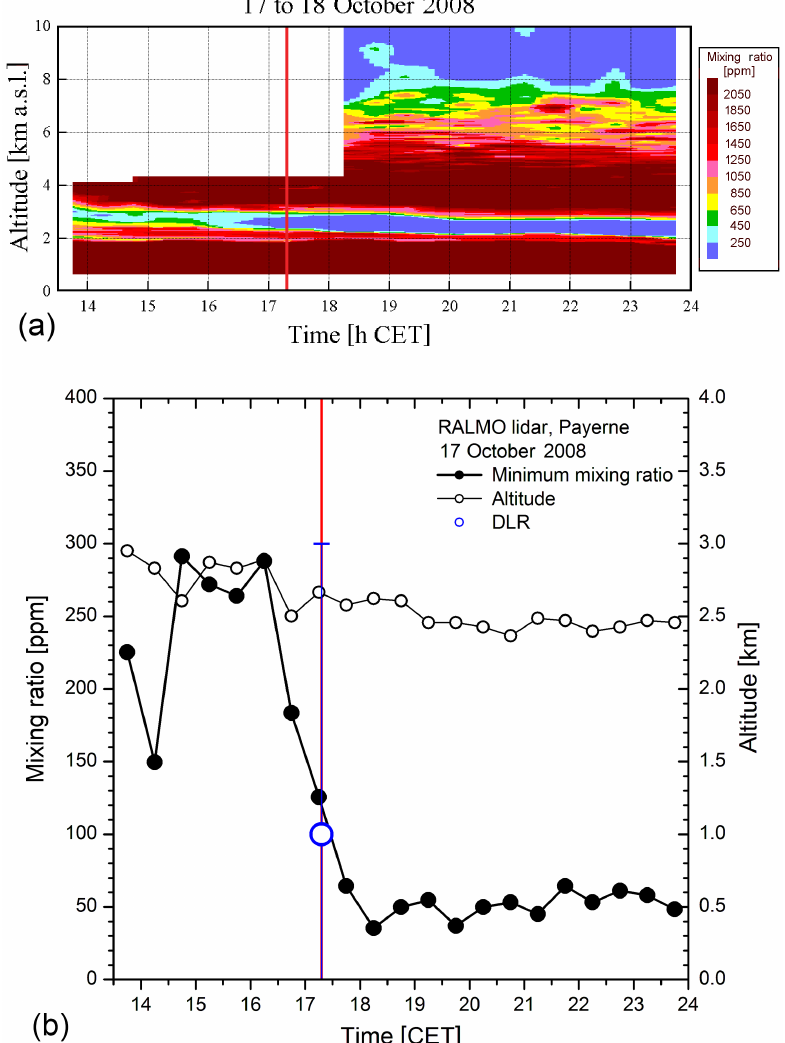
Figure 3. (a) Water-vapour time series of RALMO on 17 October 2008; the time of the aircraft overflight (17:18CET) is marked by a red vertical line. The figure is based on 0.5h averages, the times being centred in the respective measurement interval. Before 18:15CET the residual daylight background prevented measurements beyond the lower free troposphere. (b) Time series of the water-vapour minimum in the stratospheric intrusion layer on 17 October 2008, as recorded by RALMO, and the corresponding altitude; the time of the aircraft overflight (17:18CET) is marked by a red vertical line. The figure is based on 0.5h averages, the times being centred in the respective measurement